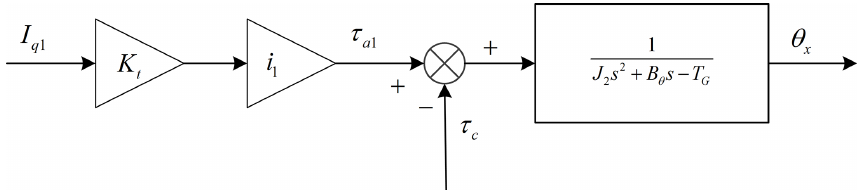
Figure 12. Simplified structure